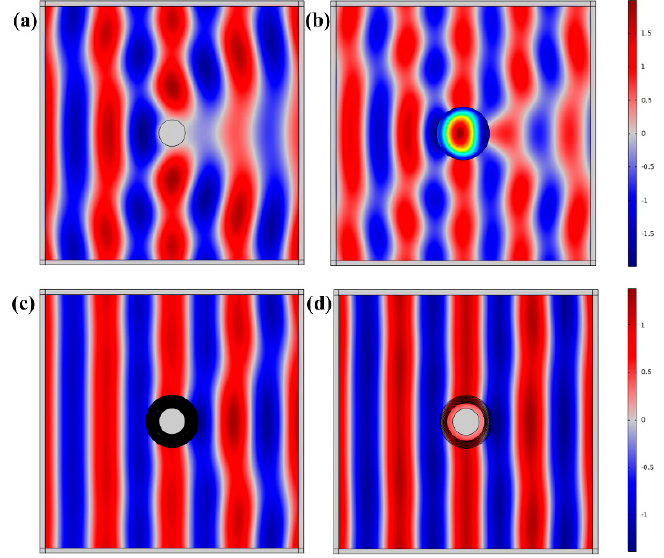
Figure 13. Scattering pressure field distribution: ( a ) uncloaked cavity; ( b ) titanium alloy cylinder with a radius of 1 m; ( c ) latticed cloak; ( d ) homogeneous cloak.